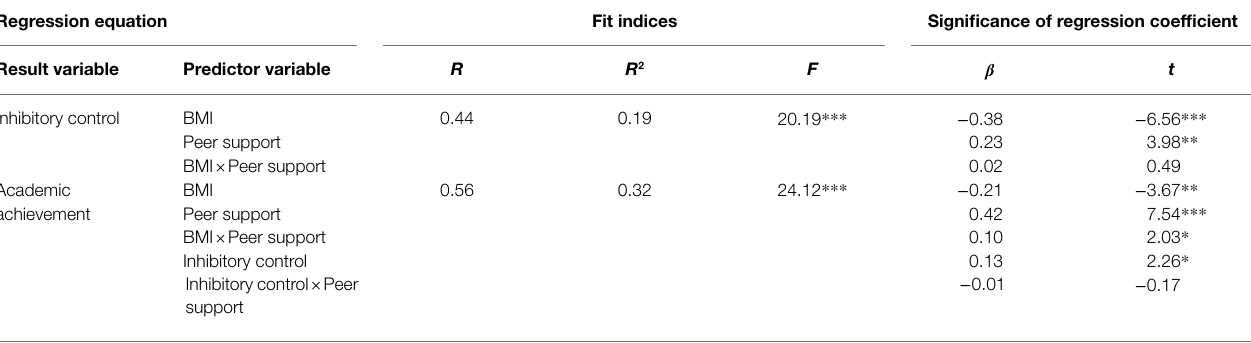
TABLE 7 | The moderating effect of the peer support on the mediating